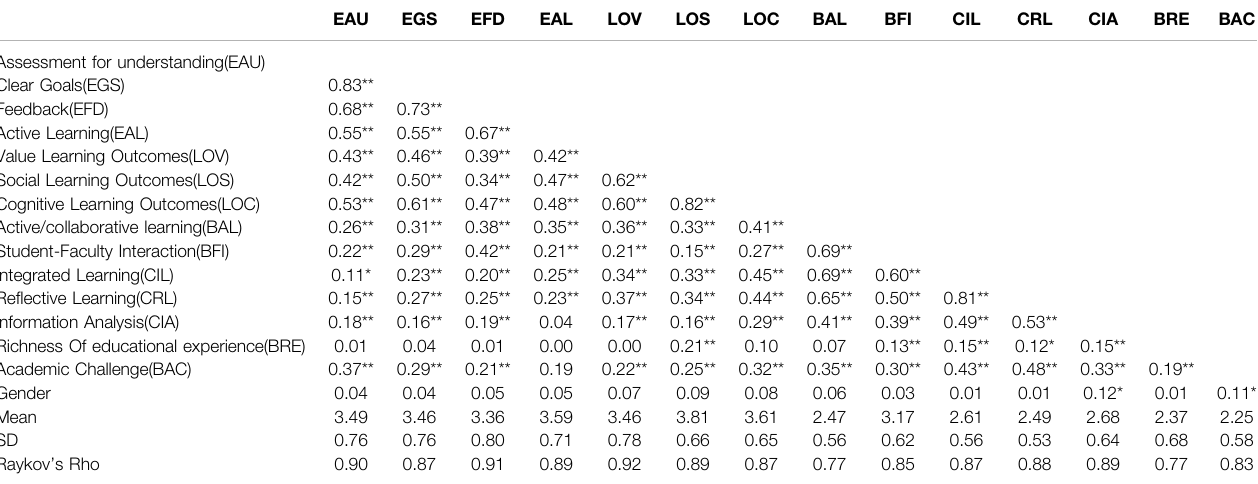
TABLE 3 | Correlations, means, SD and Raykov ’ s